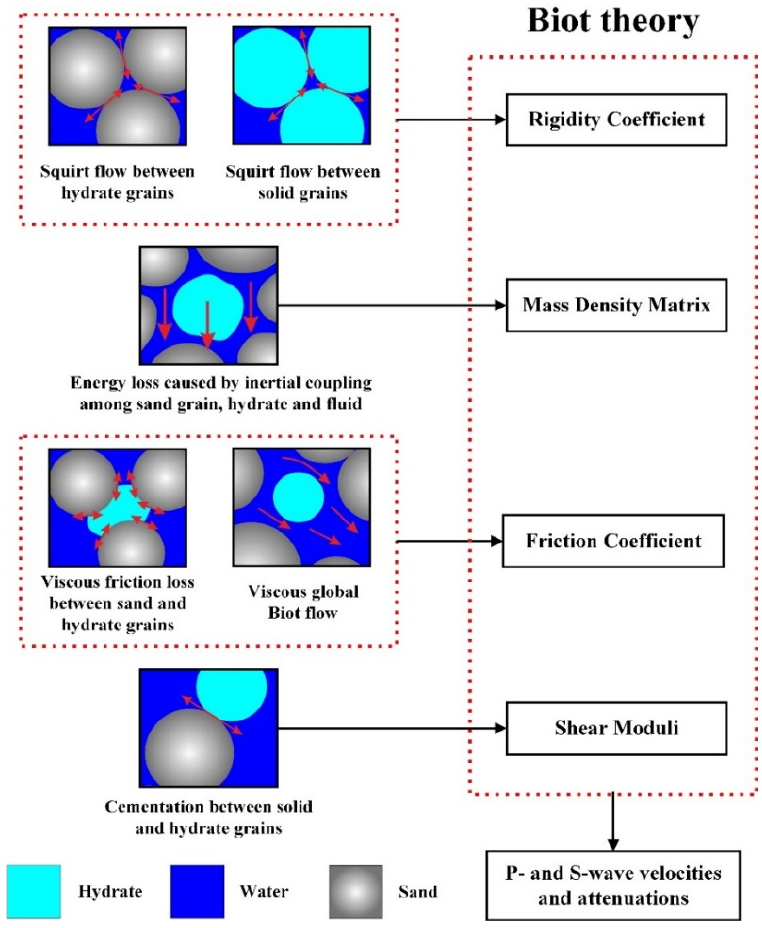
Figure 5. Workflow of the three-phase Biot-extension model.